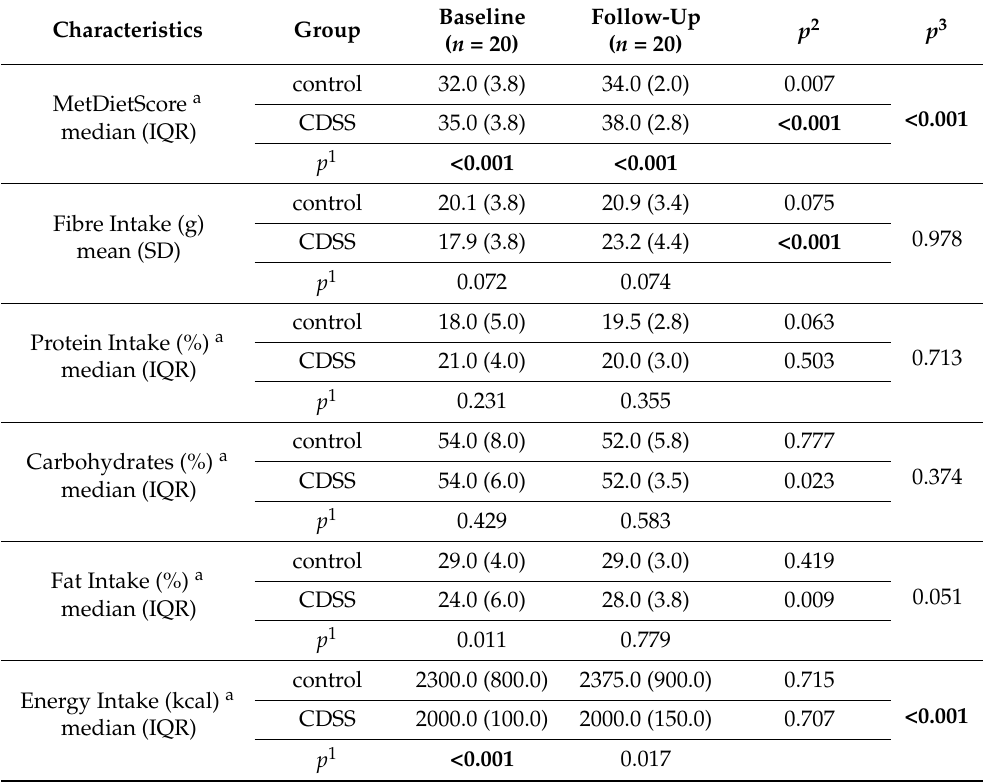
Table 4. Dietary intake at baseline and follow-up.